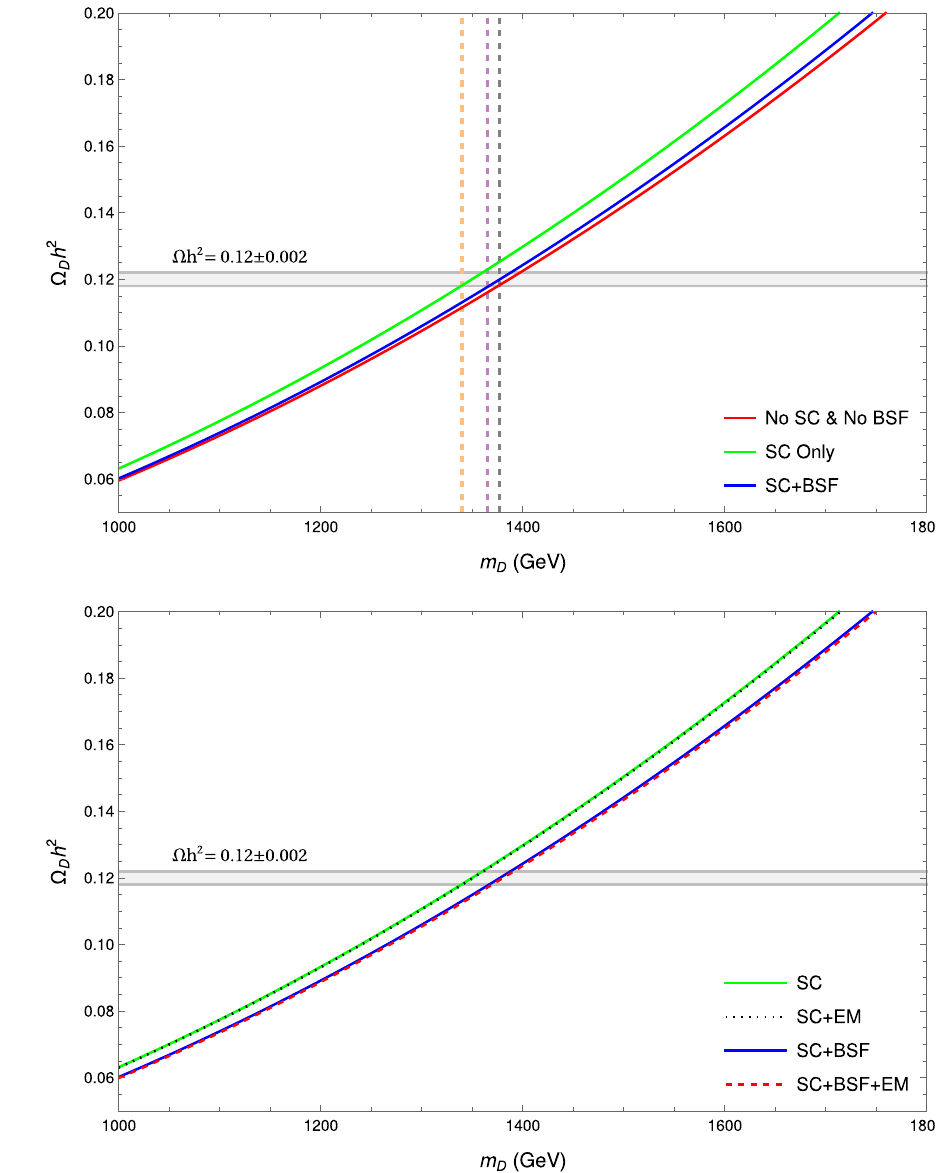
Fig. 7 DM relic density plotted against its mass for three different cases: perturbative calculation (red solid line) without Sommerfeld correction (SC) and bound state formation (BSF), perturbative calculation with SC in S -wave (green solid line), and by considering both SC and BSF (blue solid line).